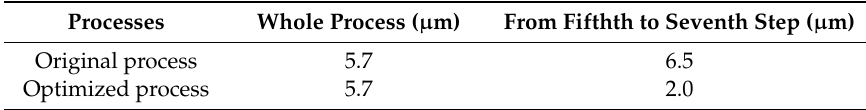
Table 3. The average differences between the adjacent data